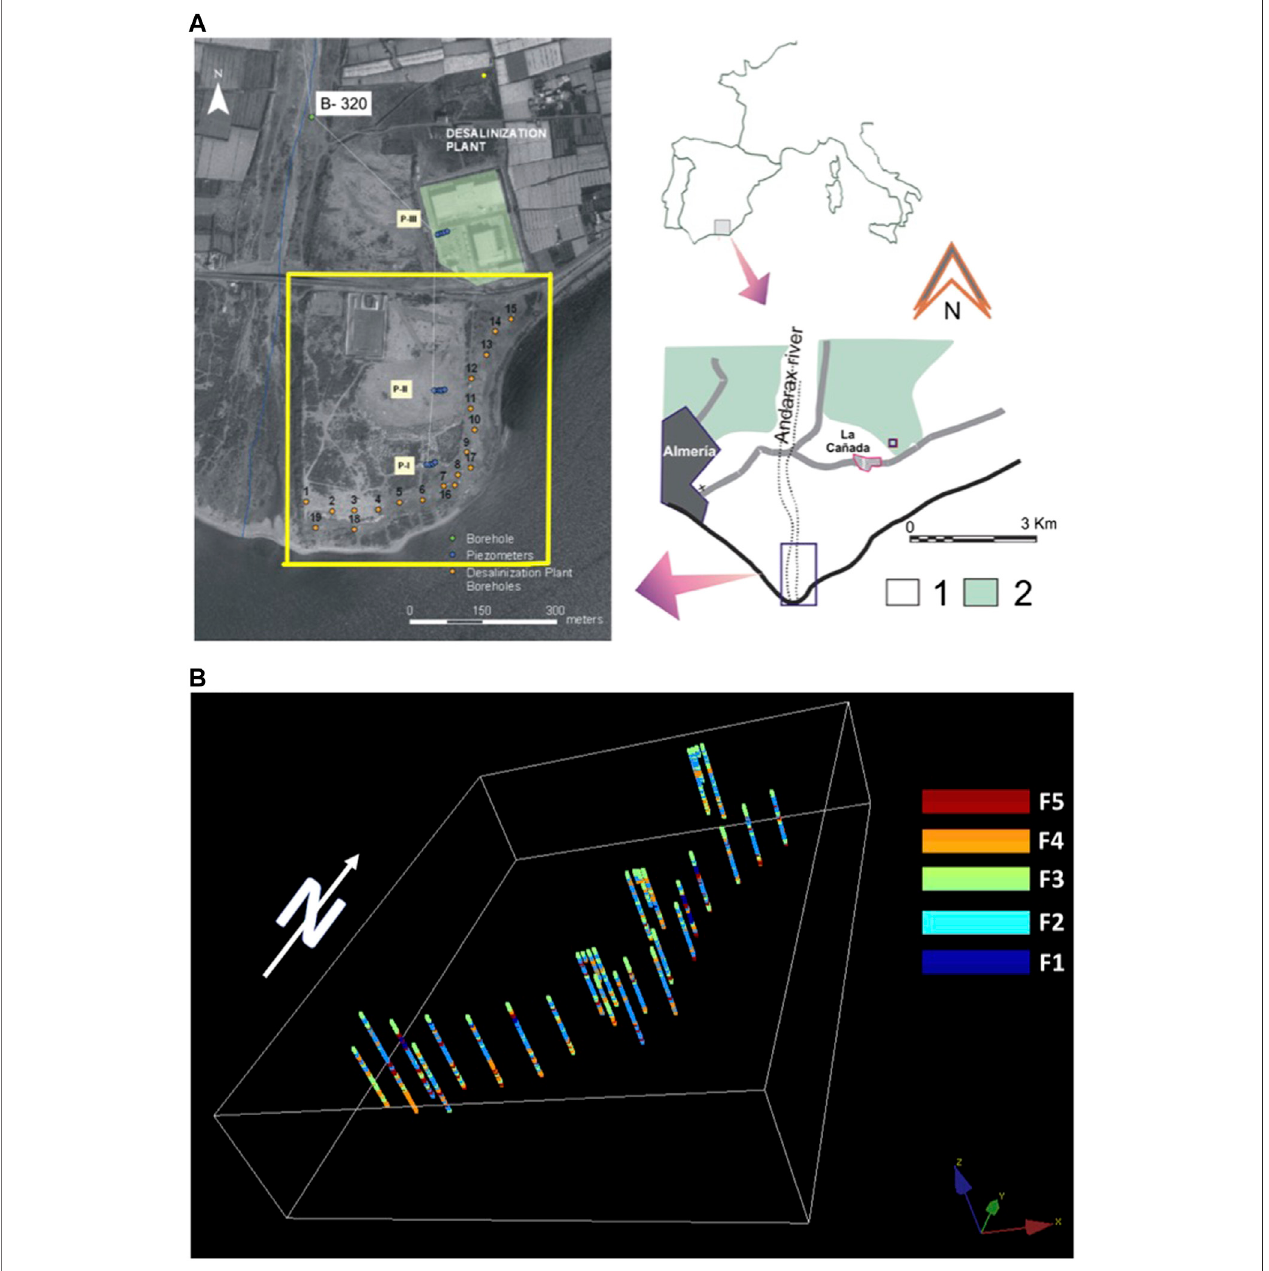
FIGURE 2 | (A) Location of the study area in the Andaraxriver delta. The yellow square is the area of the case study in which there are 19 boreholes and three clusters of four piezometers. The numeral 1 denotes detrital material from the Quaternary and 2 from the Pliocene. (B) Data for the fi ve hydrofacies (F1 to F5) within boreholes and piezometers. The color legend ranges from very permeable (dark blue (cid:1) F1) to very impermeable (dark red (cid:1) F5).